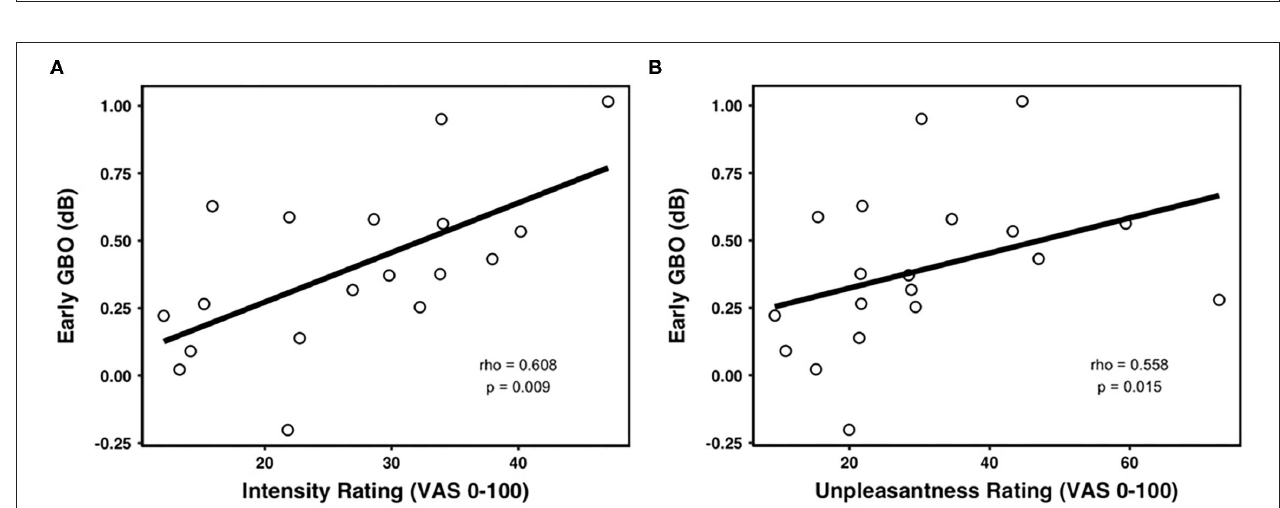
FIGURE 4 | Correlations between the early GBOs and pain ratings. The mean early GBO was significantly positively correlated with (A) averaged intensity rating and (B) averaged unpleasantness rating across valence.